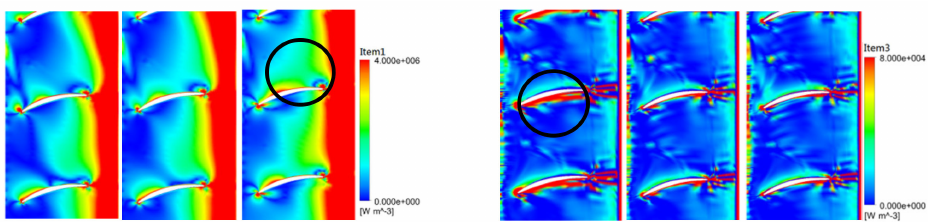
Figure 11. Distribution of the losses for impeller ( left : 0.5 Ud, middle : 1.0 Ud, right : 1.7 Ud).